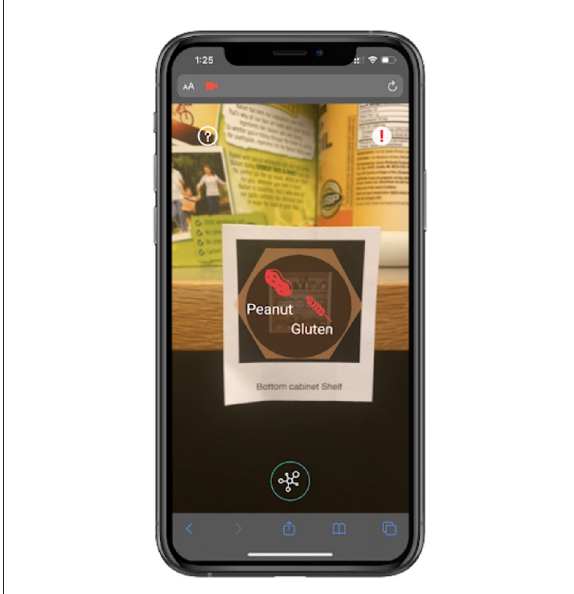
FIGURE5 Information page that appears about the data sample once the user clicks on the AR info from Figure